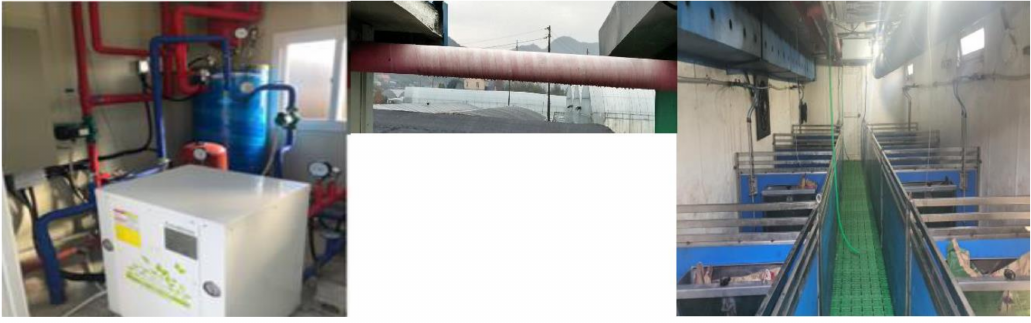
Figure 2. Schematic diagram of the geothermal heat pump (GHP) system for the pig house.